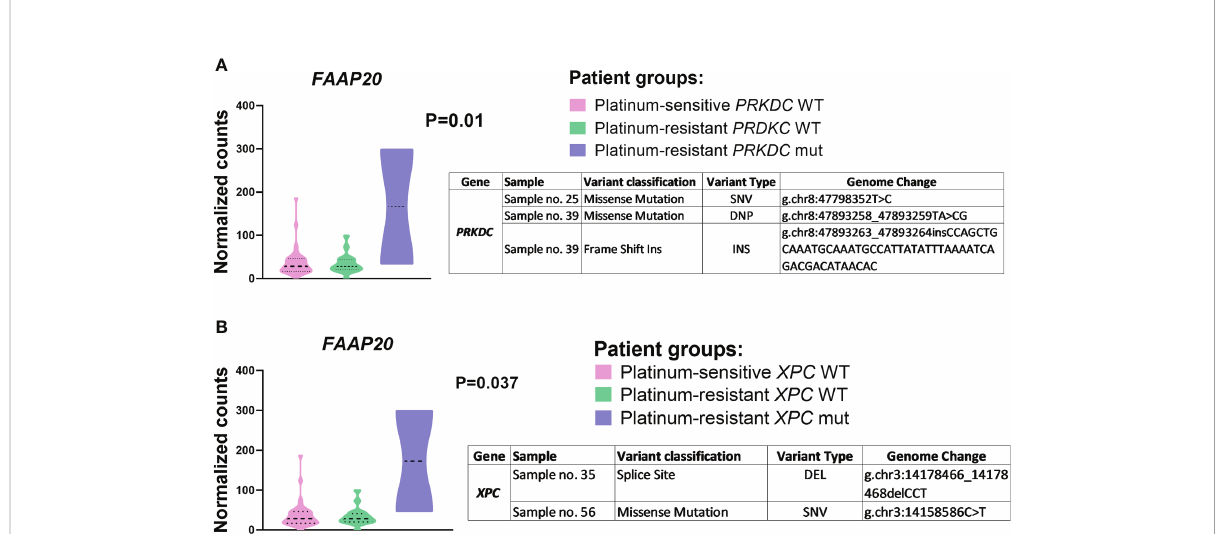
FIGURE 4 FAAP20 gene expression compared to (A) PRKDC and (B) XPC mutations. Differential expression of FAAP20 between patient groups – platinum- sensitive (N = 32, pink color), platinum-resistant harboring mutant PRKDC/XPC genes (N = 2, purple color) and platinum-resistant harboring wild type PRKDC/XPC genes (N = 18, green color). All P-values are declared after adjusting for FDR. Patients were divided based on the platinum